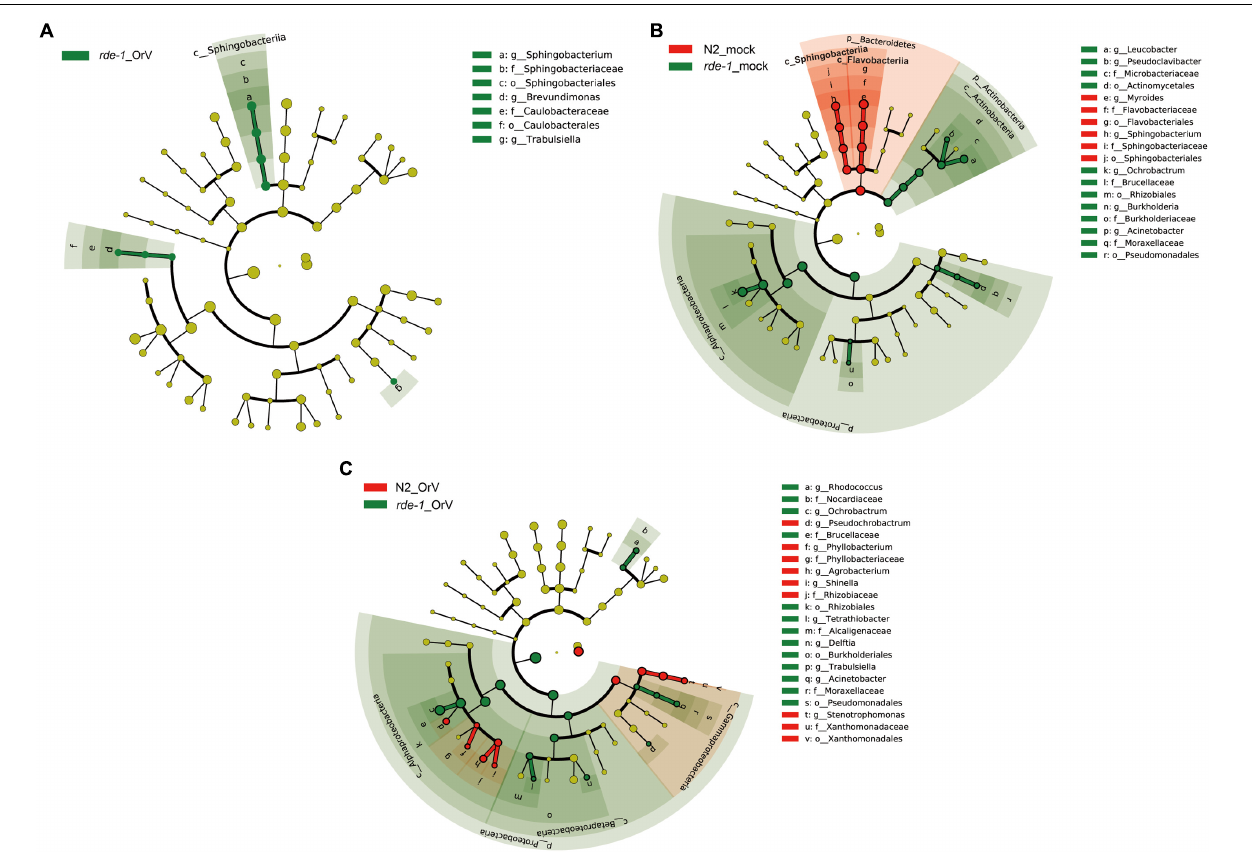
FIGURE 4 | rde-1 (ne219) mutant and N2 animals harbor distinct bacterial communities. (A) LEfSe analysis of microbiomes between uninfected and Orsay virus-infected group in rde-1 ( ne219 ) mutants. The taxa that were found at a significantly higher relative abundance in Orsay virus-infected group (green) relative to the uninfected samples are highlighted. (B) LEfSe analysis of microbiomes between uninfected N2 and rde-1 ( ne219 ) mutants. (C) LEfSe analysis of microbiomes between Orsay virus-infected N2 and rde-1 ( ne219 ) mutants. The taxa that were found at a significantly higher relative abundance in N2 (red) and rde-1 ( ne219 ) (green) are highlighted. For the cladogram, yellow circles represent non-significant microbial